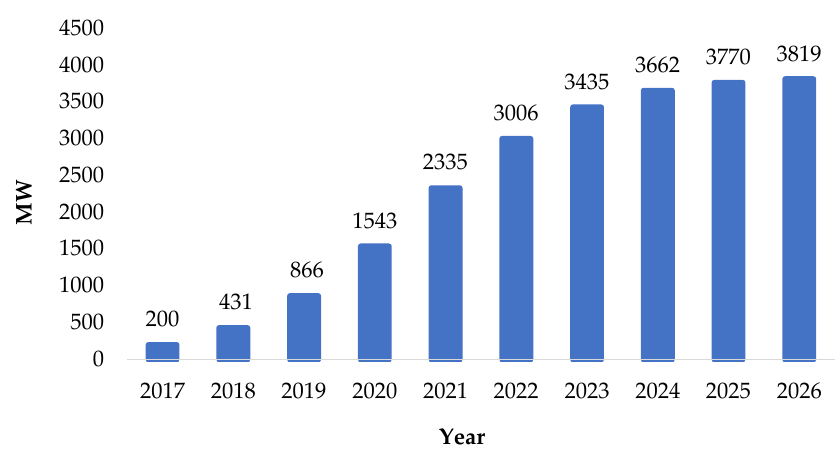
Figure 2. The column chart of estimated annual RSPS growth data exist in [23] for Turkey.